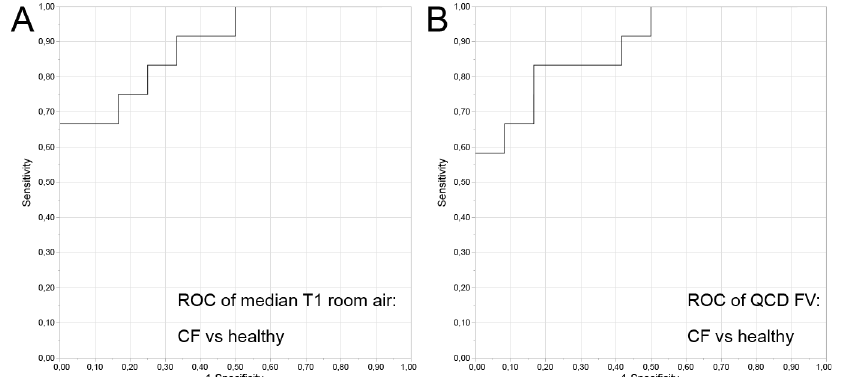
Fig 4. Receiveroperator characteristic analysis (ROC). Receiveroperatorcharacteristic (ROC) analysis with clinical diagnosis as the criterion showedthe ability of functionalMRI to discriminate young adults with CF from healthy volunteers. A: Room air T1 (cut point: 1200 ms; area under the curve (AUC) 0.89); B: Quartile coefficient of dispersionof fractional ventilation(cut point 0.351; AUC 0.89).